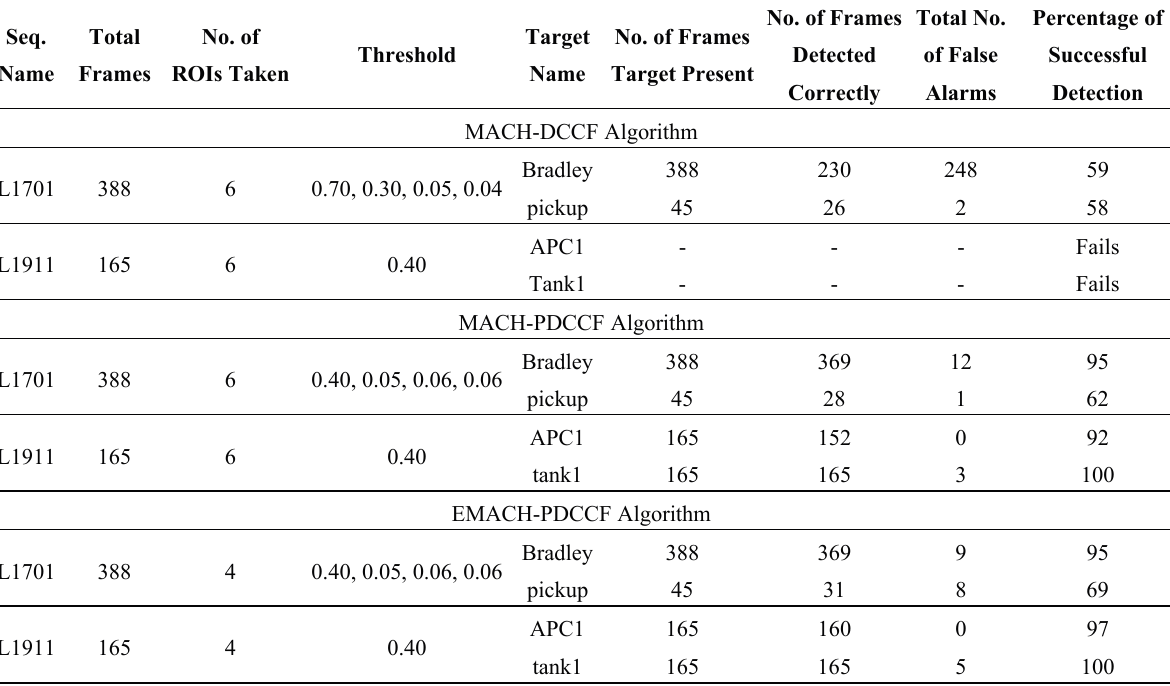
Table 8. Tracking results of two-target